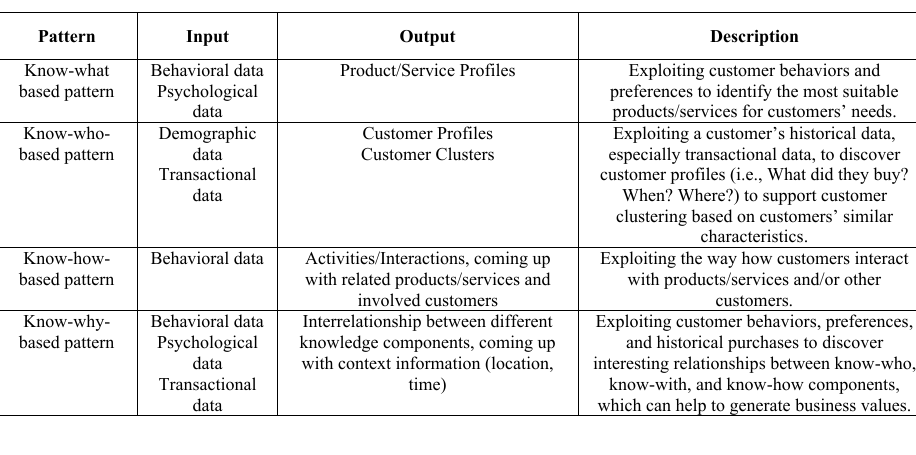
Table 1. Knowledge reasoning patterns.